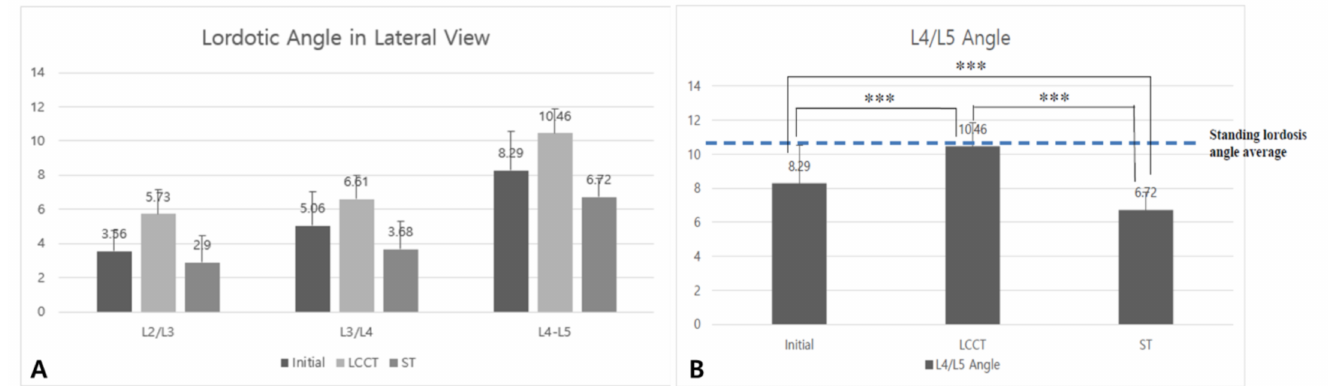
Figure 4. ( A ) The intervertebral disc angle in each vertebra. ( B ) In L4/5 level in three condition. Standing lordosis angle average is 10.9. Our patient in the initial group has the lowest L4/L5 angle and LCCT group has the highest L4/L5 angle. It has statistical significance among initial, LCCT, and ST ( p = 0.000